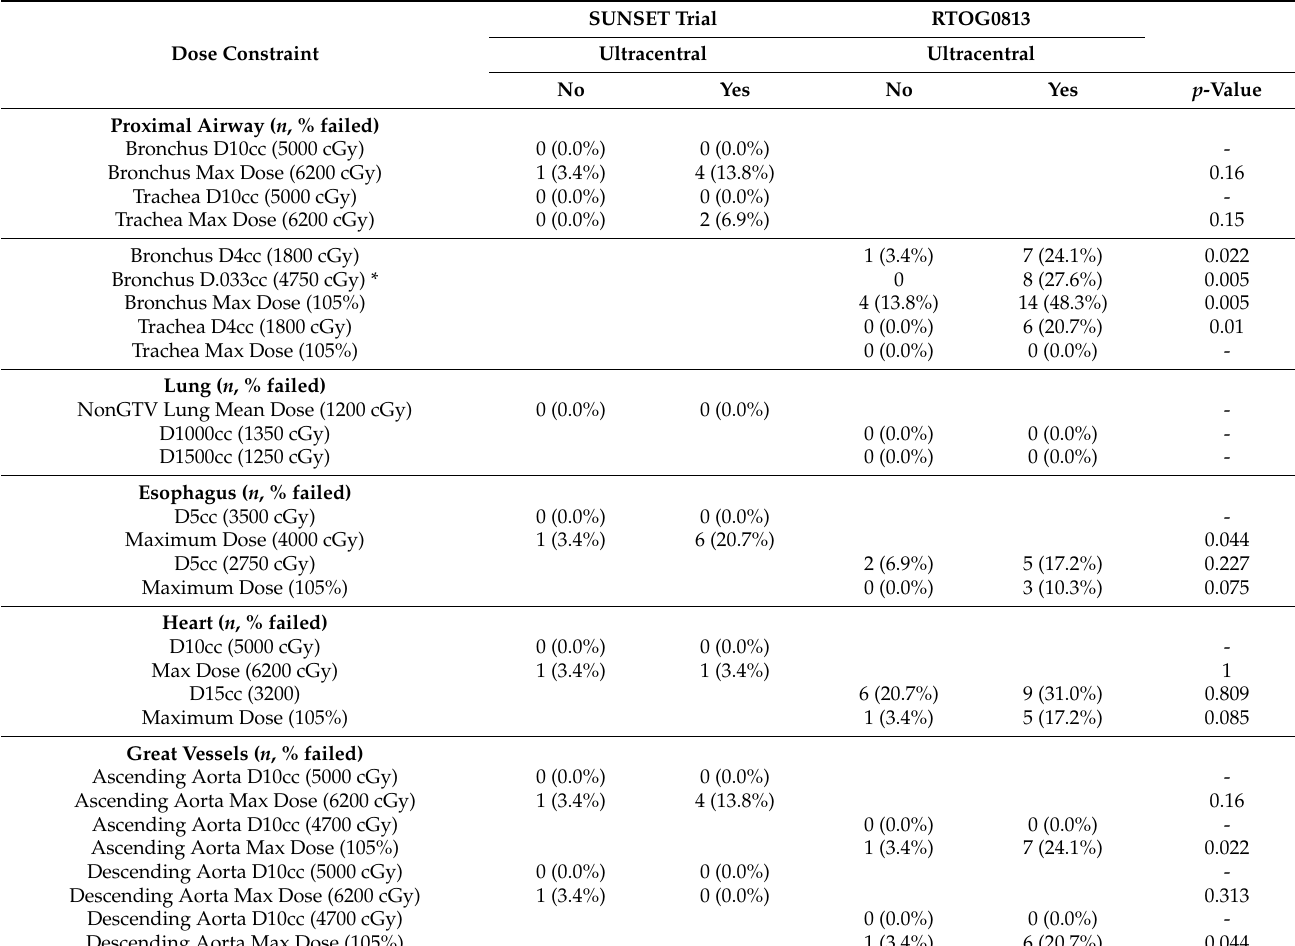
Table 4. Failure of RTOG 0813 and SUNSET dose constraints.